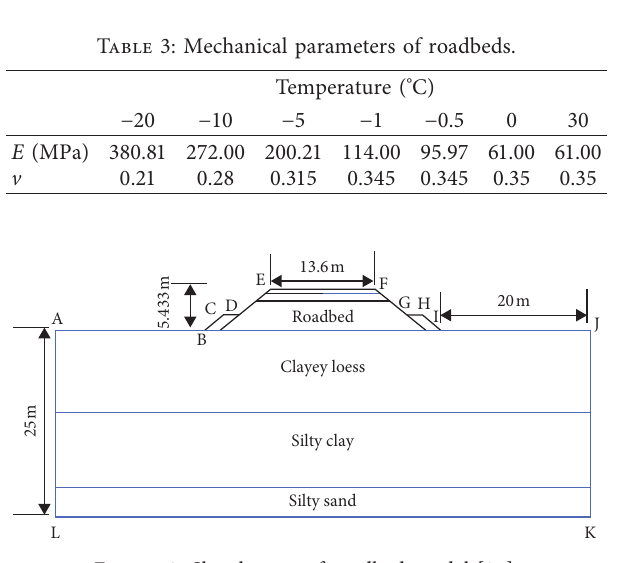
Figure 3: Sketch map of roadbed model [27].